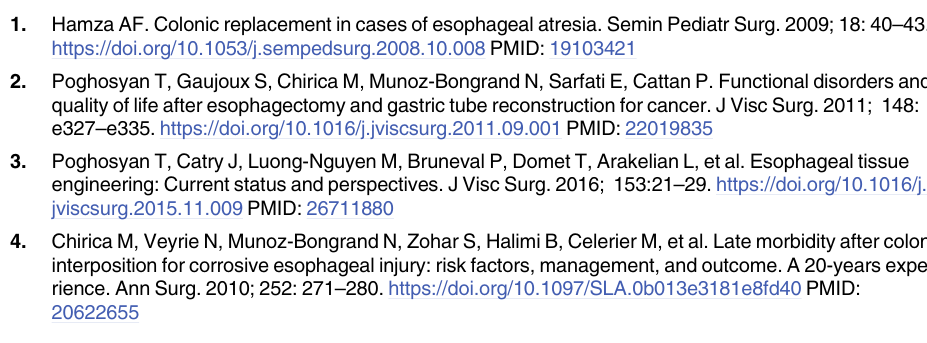
S1 Table. Individual data of the structures and esophagus of